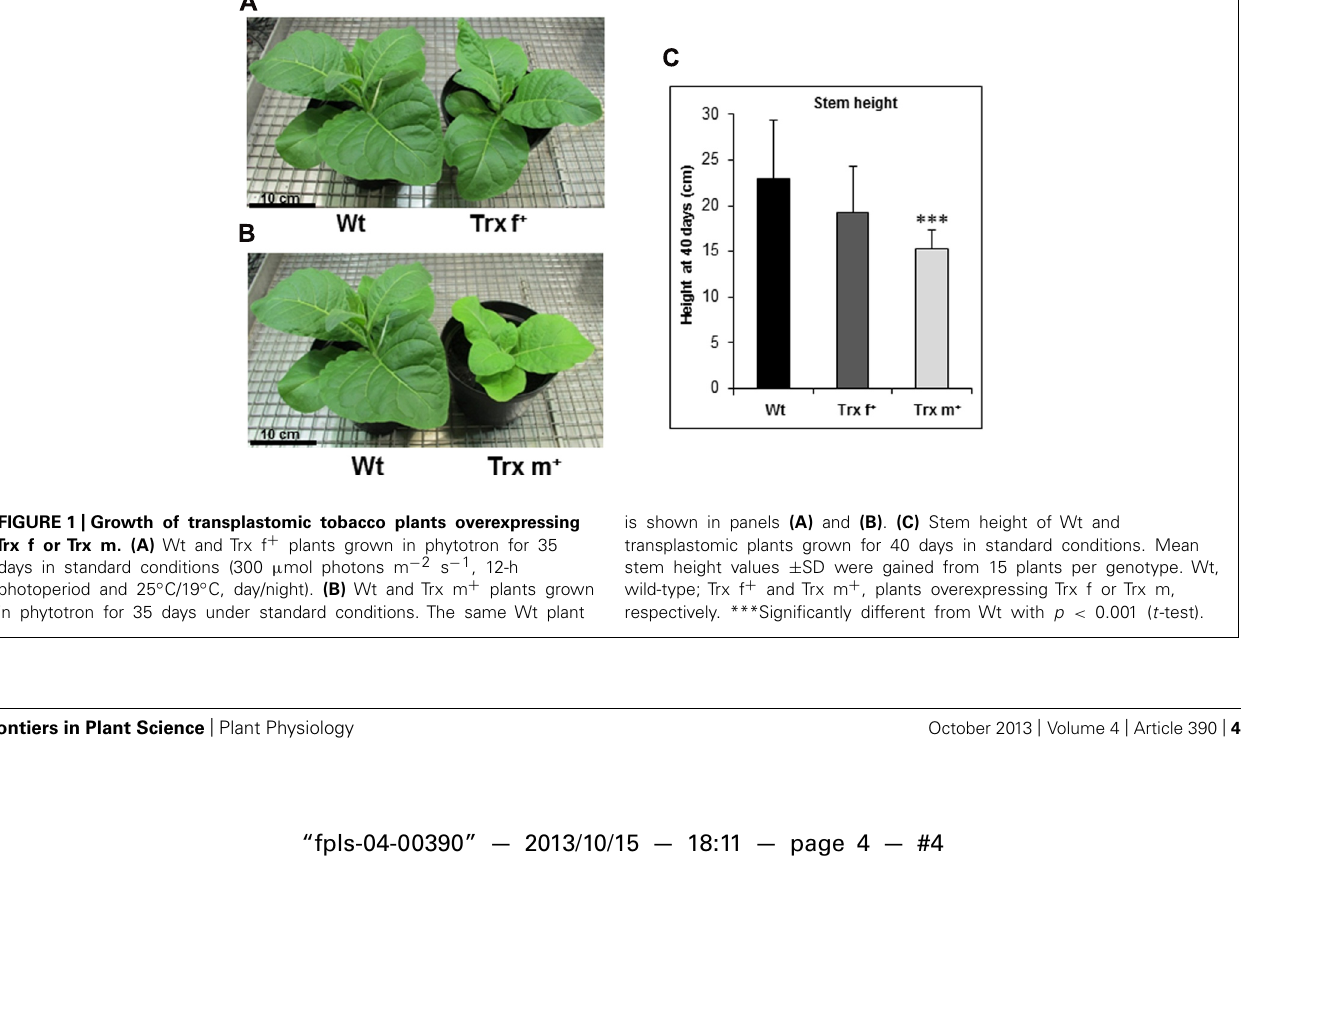
FIGURE 1 | Growth of transplastomic tobacco plants overexpressing Trx f or Trx m. (A) Wt and Trx f + plants grown in phytotron for 35 days in standard conditions (300 μ mol photons m − 2 s − 1 , 12-h photoperiod and 25 ◦ C/19 ◦ C, day/night). (B) Wt and Trx m + plants grown in phytotron for 35 days under standard conditions. The same Wt plant